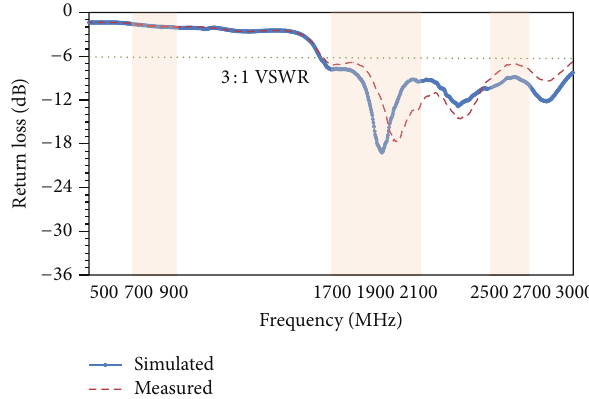
Figure 4: Simulated and measured VSWR of the proposed antenna at V 1 port.